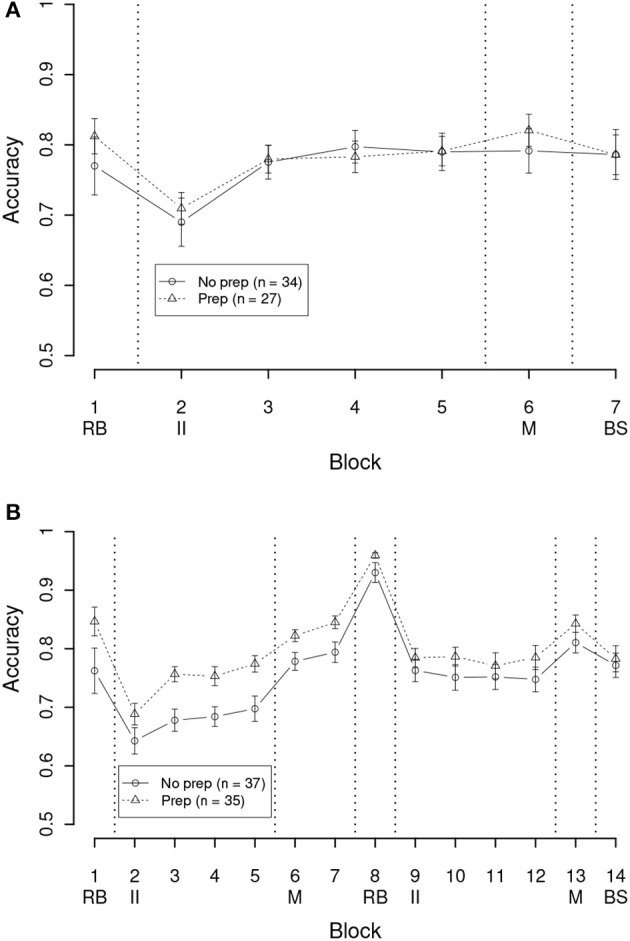
Mean accuracy per block in the experiment. Vertical dashed lines indicate a change of trial type, and the letters under the block numbers indicate the beginning block of a trial type: RB, Rule-based; II, Information-integration; M, Mixed trials (interleaved); BS, Button-switch trials. (A) Conditions with 1 training session. (B) Conditions with 2 training sessions. Error bars are between-subject standard error of the mean.